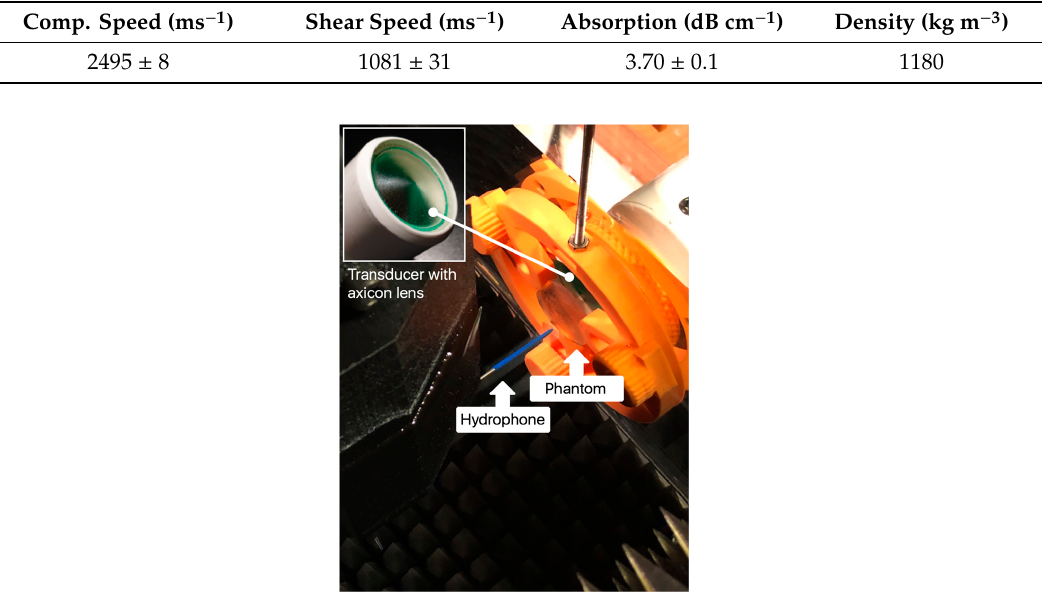
Figure 2. Photograph of the ultrasound test tank showing the axicon lens equipped transducer detail, parietal bone phantom, and